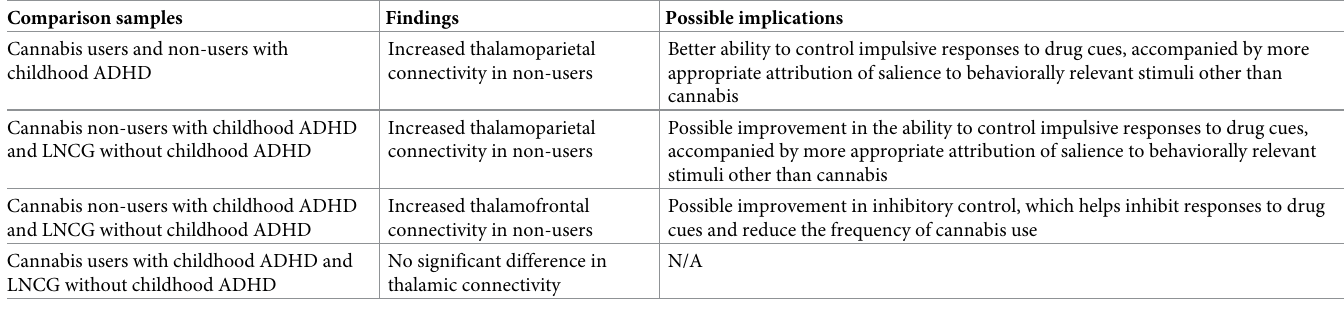
Table 4. Summary of findings and possible